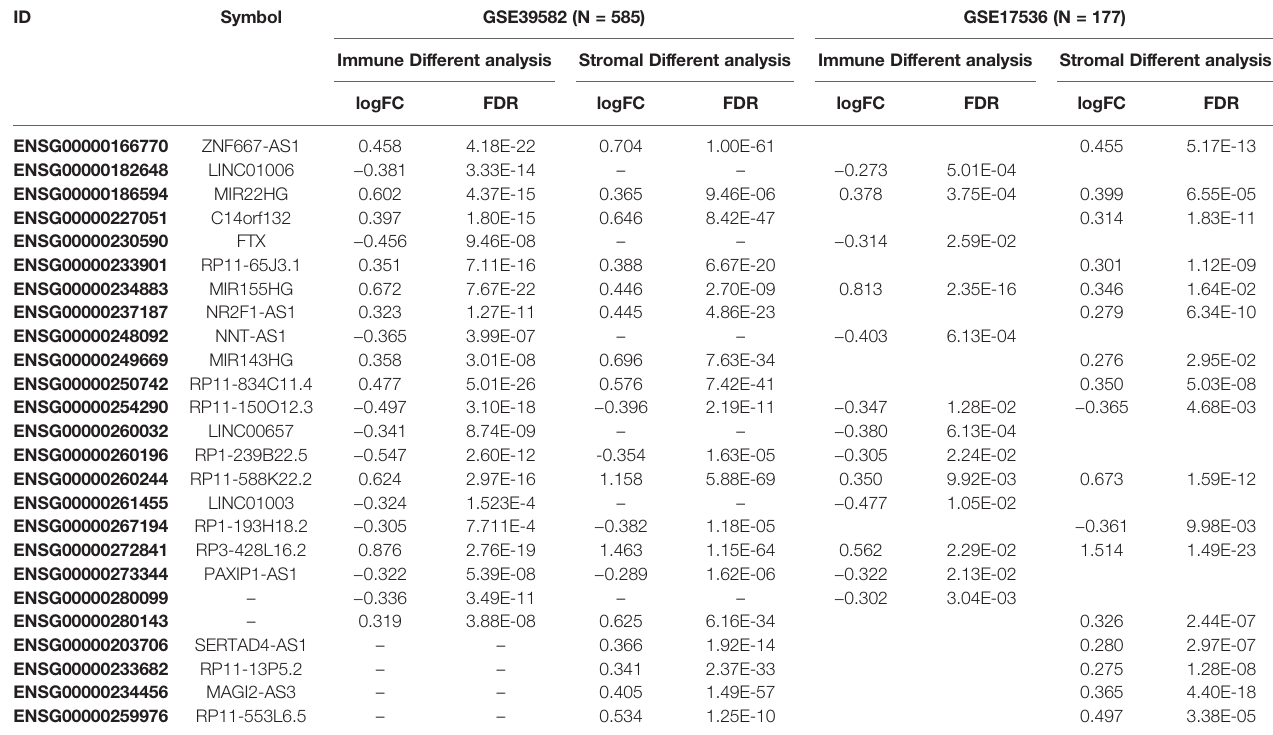
TABLE 1 | Basic information of 25 candidate lncRNAs.